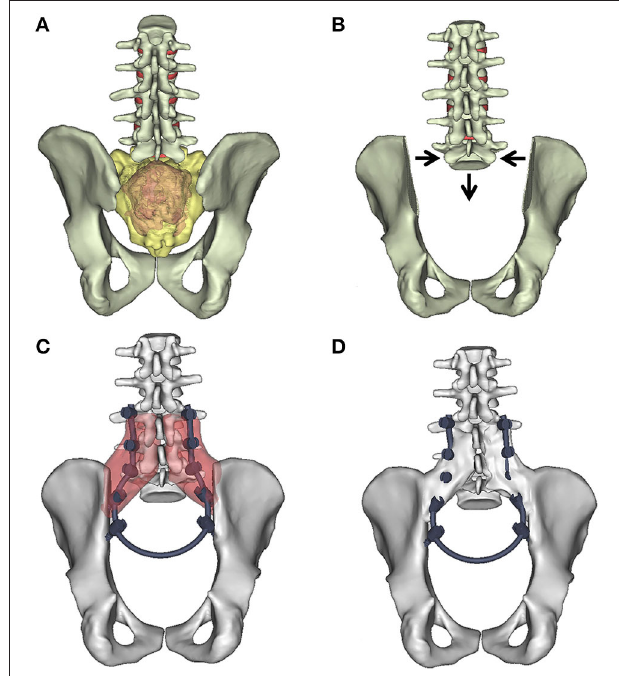
FIGURE 1 | “Closed-Loop” lumbosacral reconstruction technique after total en-bloc sacrectomy. (A) Extended tumor mass affects the whole sacrum. ( B) Geometrical change in the 3D geometry of the spino-pelvic junction after en-bloc total sacrectomy. The iliac bone is cut by an oscillating saw bilaterally; the medial cortical surface of the iliac bone is left on the specimen. The lumbosacral facet joints with the intervertebral discs are removed. The dural sac (together with the cauda equina) is cut through immediately below L5. The distance between the L5 vertebra and the iliac bone is reduced (direction of the arrows). (C) In the L3–5 vertebral body and bilaterally into the iliac bones, screws are inserted and connected with a single 5.5mm diameter “U” shaped rod according to the patient’s reduced (C) local dimensions and attached to the screws. The red areas mark the place for the artificial bone substitute, mixed with autologous bone graft. (D) The re-established connection between the lumbar spine and the pelvis. At the side of the graft ( D ) after 2 years bony fusion is